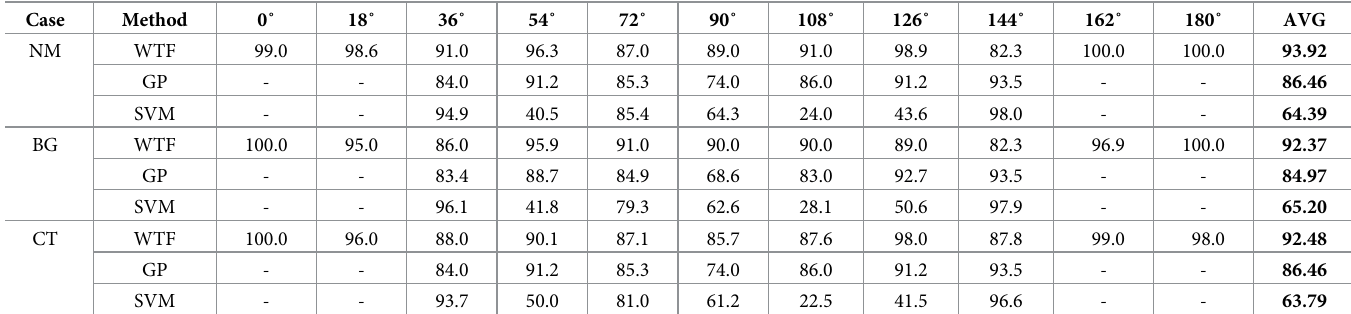
Table 2. View estimation results (%) for each view on CASIA-B. Case Method